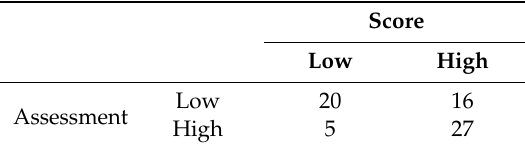
Table12. Multivariatefrequencydistributionofthescoresandassessmentclassifiedbylevels(low / high).